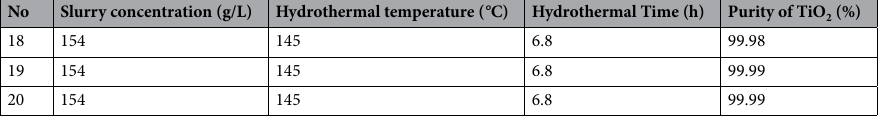
Table 4. Results of verification test.